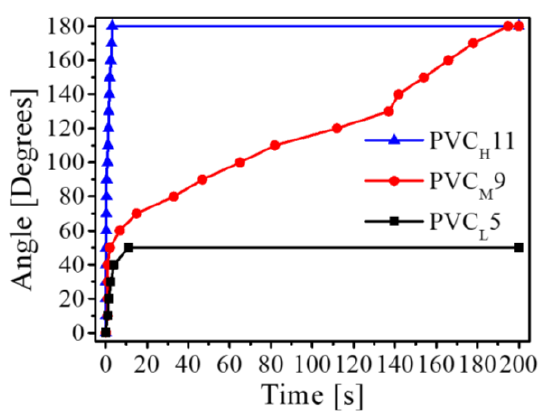
Figure 11. Bending angles of three PVC gels: PVC L 5, PVC M 9 and PVC H 11.